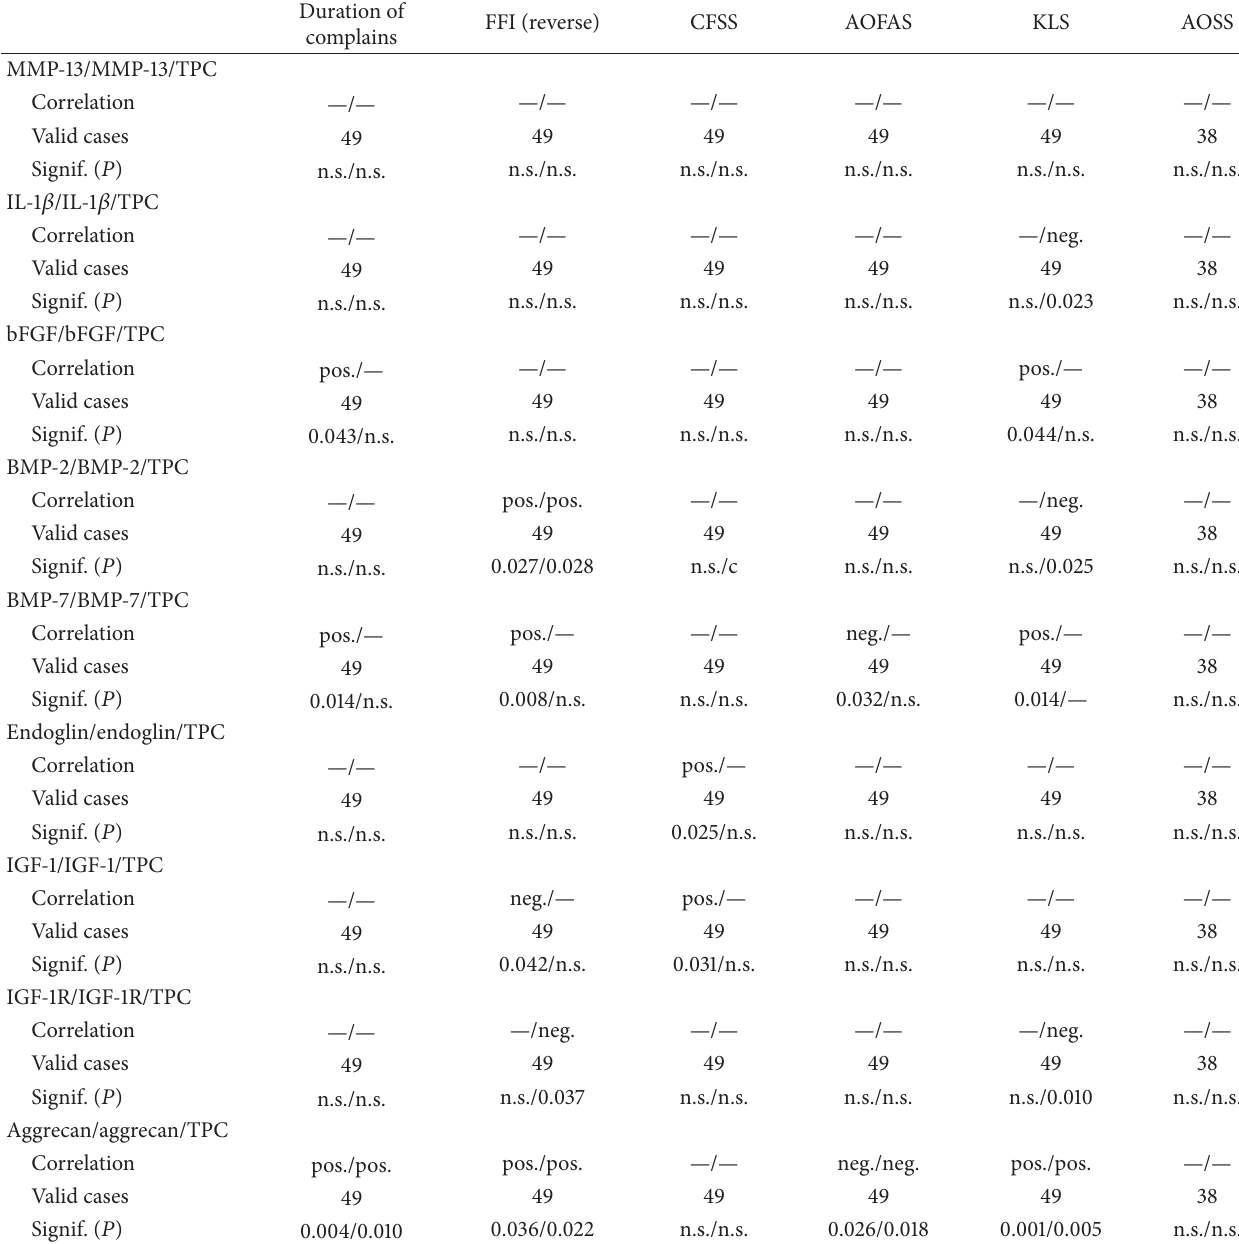
Table 2: Correlation of intra-articular protein levels with duration of complains, functional scores, and OA-related changes in conventional X-ray or